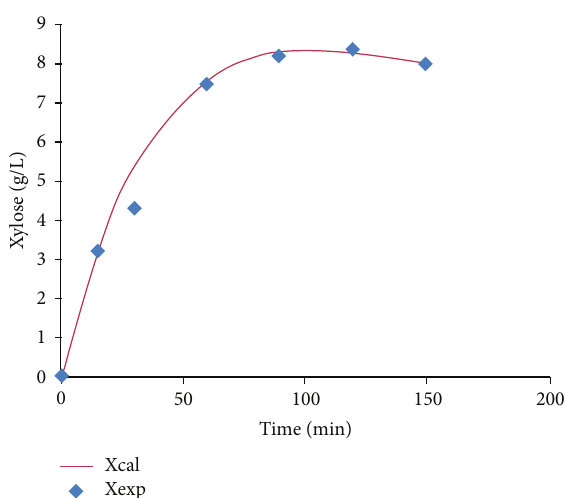
Figure 1: Comparison between calculated and experimental value of xylose in hydrolysis of OPEFB with 2 % H 2 SO 4 at 120 ∘ C [95].